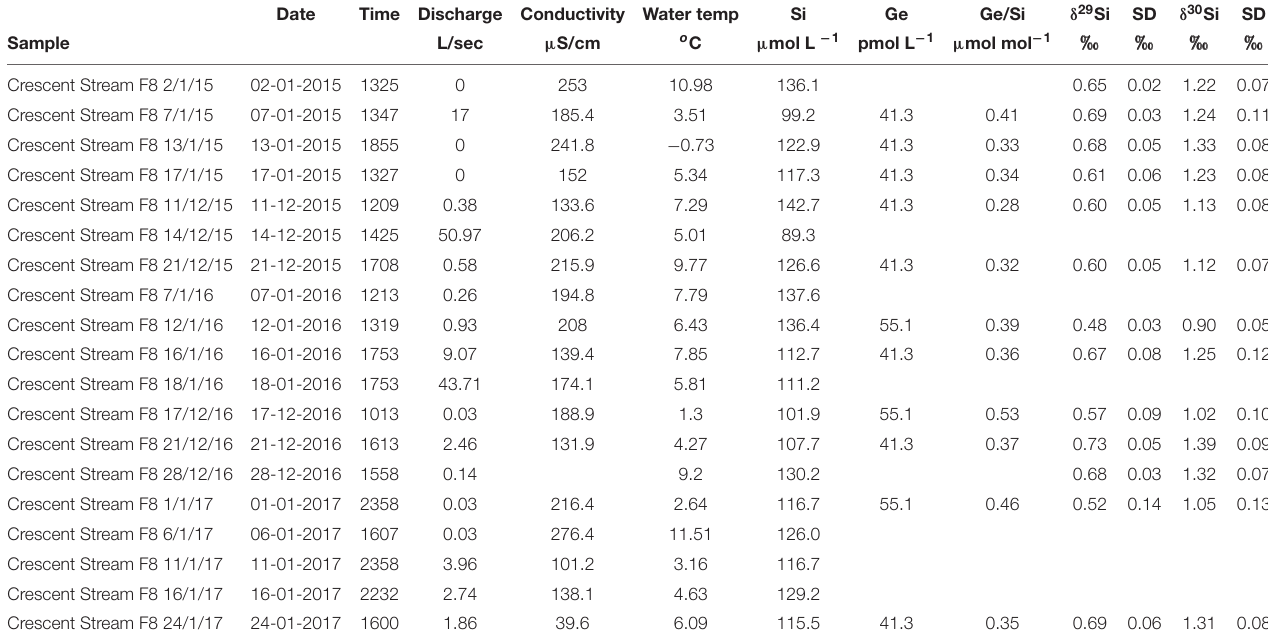
TABLE 1 | Sampling date, time, field measurements (discharge, conductivity, and water temperature), dissolved silicon and dissolved germanium concentrations, Ge/Si ratios, and silicon isotope compositions (SD) for all samples in this study collected in the austral seasons: 2014 − 2015, 2015 − 2016, and 2016 − 2017.